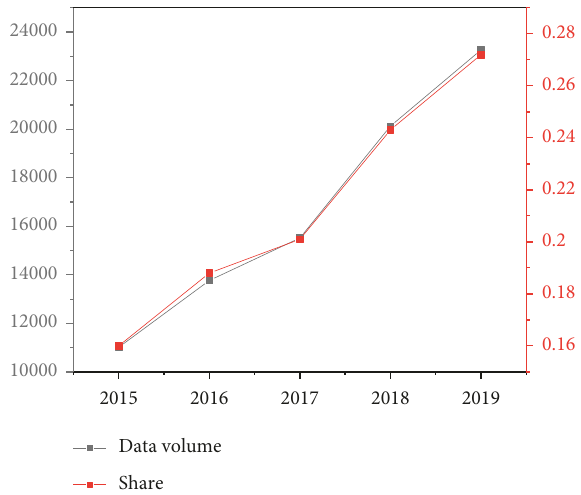
Figure 1: The user scale and the occupancy rate of online education in